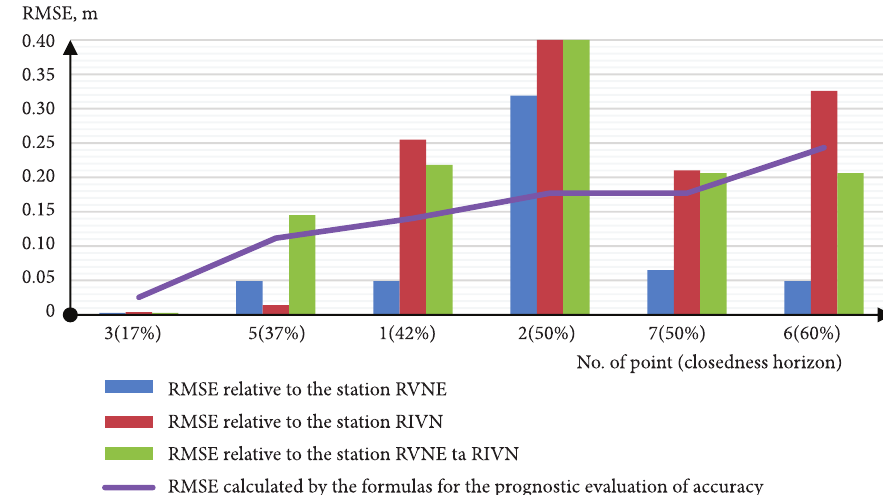
Figure 7. Comparison of RMSE of the planed location by the session duration for 1 hour and prognostic points of accuracy evaluation calculated by Equation